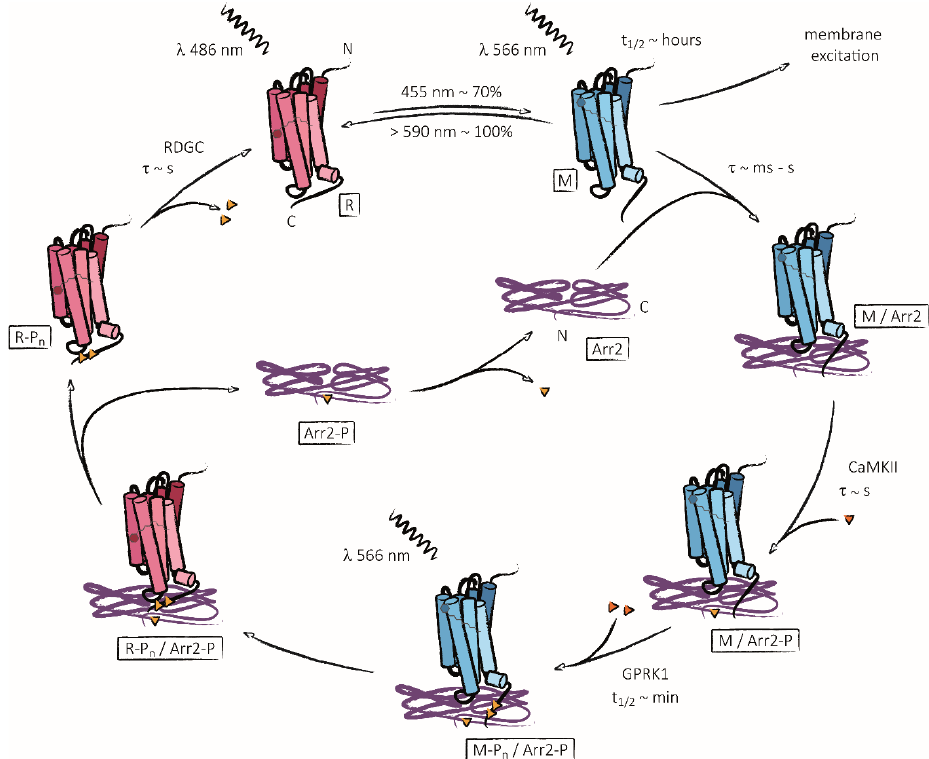
Figure 4. Schematic representation of rhodopsin photoactivation, deactivation and regeneration. Drosophila main rhodopsin Rh1 was characterized to possess a light absorption spectrum that peaks around 470–486 nm [68–71]. Absorption of a photon (depicted as sinus wave) by the chromophore 11- cis -3-hydroxyretinal results in the conformational conversion to all- trans -3-hydroxyretinal and, thus, from rhodopsin (R, fuchsia) to metarhodospin (M, blue), starting the G protein-coupled pho- totransduction cascade ending in membrane excitation. The absorption spectrum of M is shifted towards longer wavelengths with its maximum at around 560–580 nm [68–71]. Photon absorption by metarhodopsin reconverts M back to R. Due to an overlap in their absorption spectra, maximal rhodopsin activation is achieved with a wavelength of 455 nm, converting around 70% of all R mol- ecules towards M [64,65]. Reciprocally, illumination with wavelengths above 590 nm reconvert vir- tually 100% of M back to R. M has been shown to be thermally stable with a half-life (t 1/2 ) of several hours [63,72]. In a physiological context, M is bound in a 1:1 ratio by arrestin 2 (Arr2, purple) with a time constant (τ) in the range of (milli -)seconds which prevents M from further signaling through its G protein [42,51–55,60]. Phosphorylation of M-bound Arr2 is then catalyzed by Ca 2+ -dependent CaMKII in a matter of seconds [56]. With a half-life of a few minutes, Arr2-bound M is subsequently phosphorylated by GPRK1 [25,42]. Upon absorption of another photon, Arr2-bound M-P n is recon- verted to R-P n , releasing arrestin 2 into the cytoplasm. R-P n is then dephosphorylated, Ca 2+ -depend- ent, to its original state R by way of RDGC within minutes [25,41,42]. Finally, free Arr2-P is dephosphorylated to Arr2 to close the cycle. ATP is depicted as orange triangles, bound and free phosphate groups as yellow triangles.